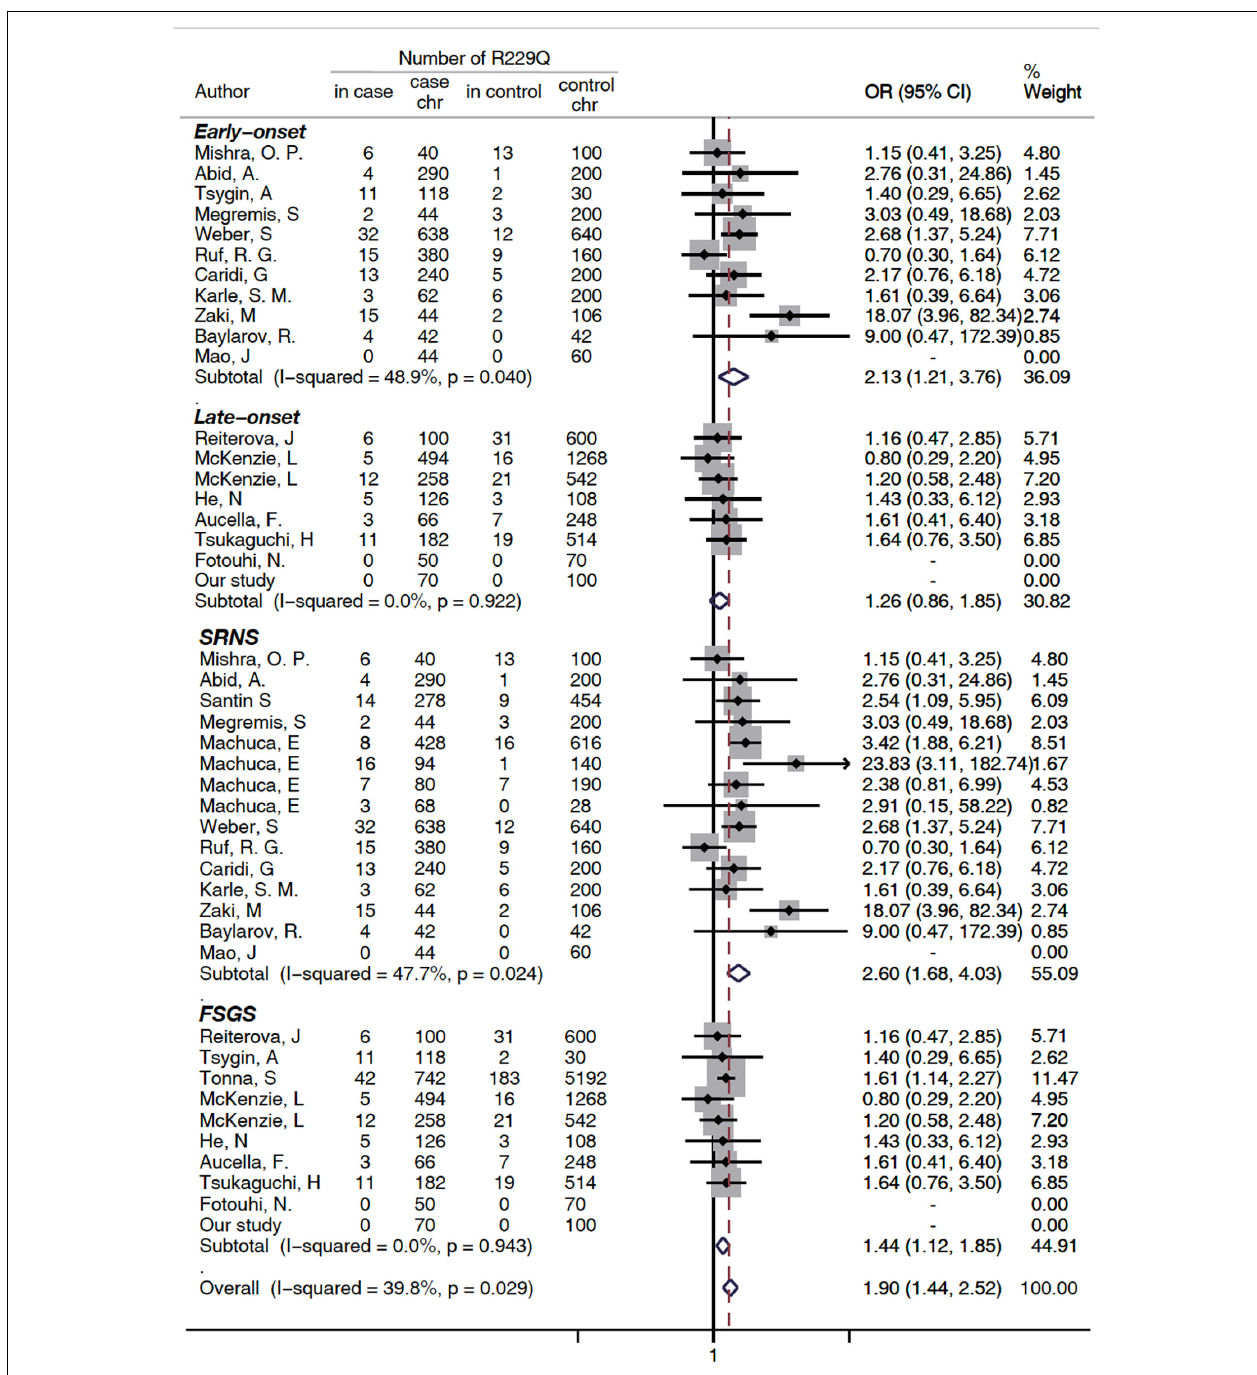
FIGURE 2 | Subgroup analysis of association between FSGS/SRNS and the p.R229Q variant based on age of onset and disease types (allelic model). CI, confidence interval; OR, odds risk; chr, chromosome; SRNS, steroid-resistant nephrotic syndrome; and FSGS, focal segmental glomerular sclerosis. SRNS, steroid-resistant nephrotic syndrome; FSGS, focal segmental glomerular sclerosis; HWE, Hardy Weinberg Equilibrium; NA, not available (i.e., not stated).